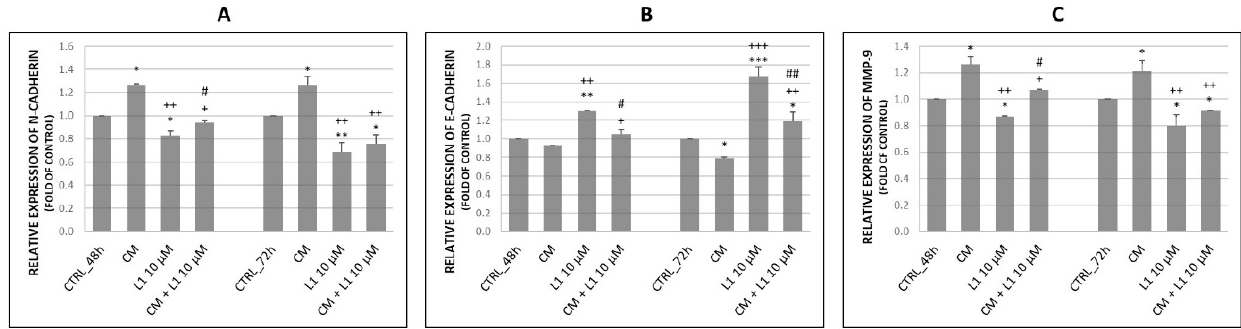
Figure 10. Changes in expression of N-Cadherin ( A ), E-Cadherin ( B ), and MMP-9 ( C ) after 48 h and 72 h of CM from BJ-5ta cells and L1 treatment. Representative data obtained by three independent experiments using flow cytometry. CM—conditioned medium. Significantly different * p < 0.05, ** p < 0.01, *** p < 0.001 vs. untreated cells (control); + p < 0.05; ++ p < 0.01, +++ p < 0.001 vs. CM; # p < 0.05; ## p < 0.01 vs. L1.